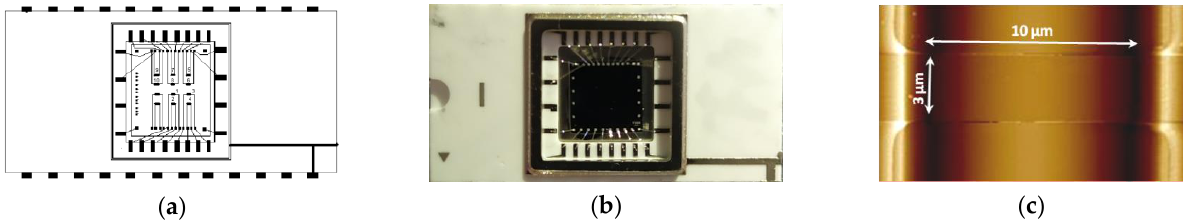
Figure 1. Schematic representation of an NR sensor chip ( a ); photographic image of an NR chip assembly ( b ); AFM image of an individual NR sensor. Arrows indicate the dimensions of the sensor ( c ).